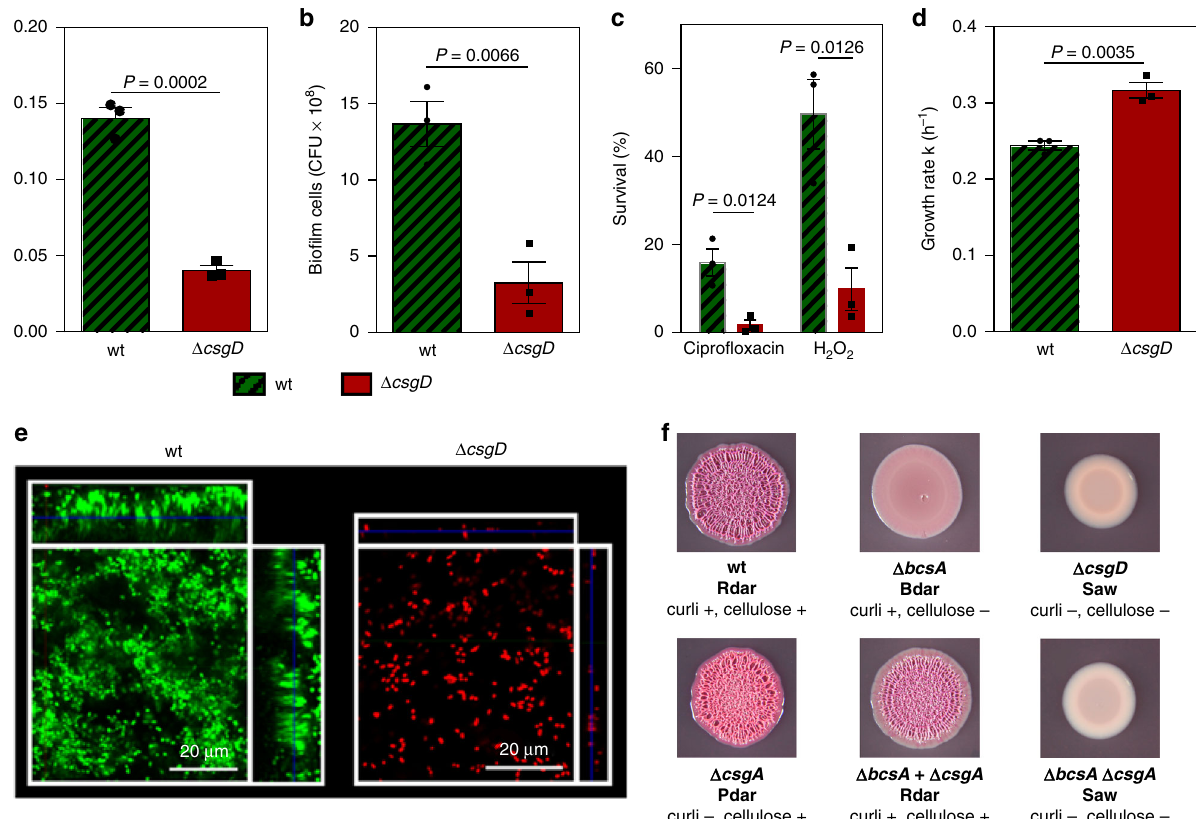
Fig. 1 Salmonella bio fi lm EPS is a public good. Wild-type S . Typhimurium strain ATCC14028 (EPS producer) is indicated in (shaded) green; the isogenic Δ csgD mutant (EPS non-producer) is indicated in red. a Amount of biomass in monoculture bio fi lms. b Number of cells in monoculture bio fi lms. c Survival of monoculture bio fi lms after treatment with cipro fl oxacin (1 µ M ) and H 2 O 2 (0.25%). d Average growth rate ( Δ CFUh − 1 ) in competition (1:1) during